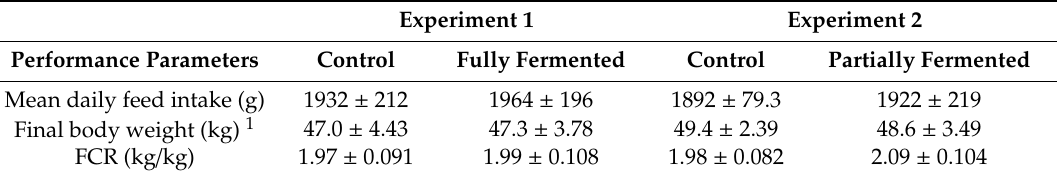
Table 2. Performance parameters of pigs depending on feeding